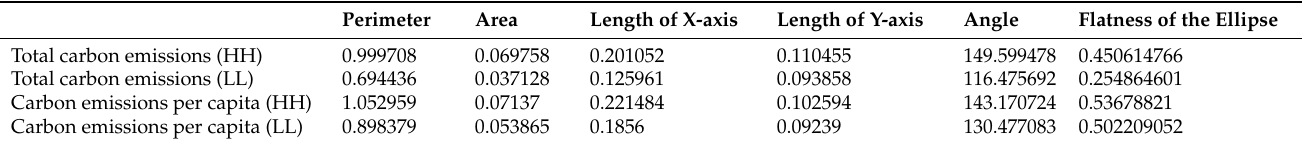
Table 7. Standard deviation ellipse parameters of total carbon emissions and per capita carbon emissions.